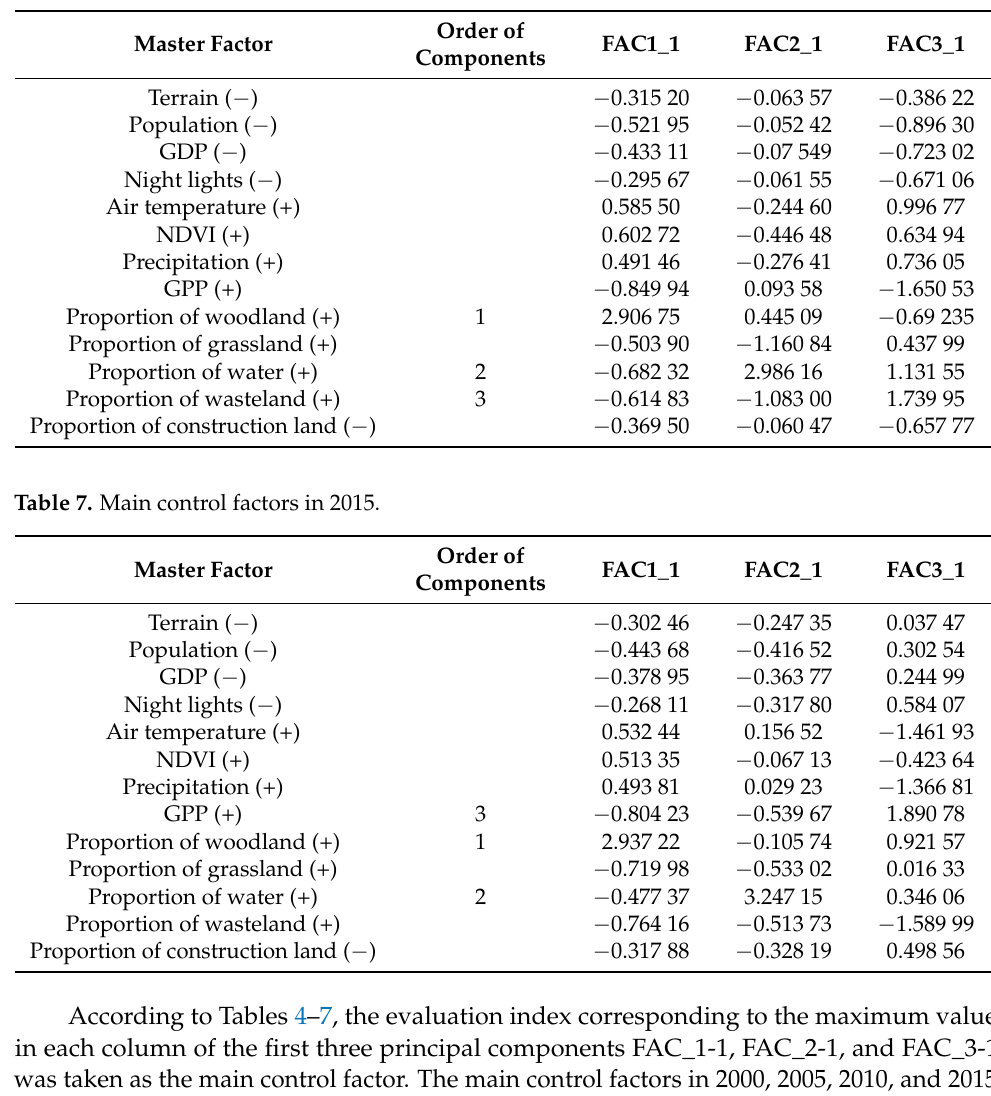
Table 6. Main control factors in 2010.